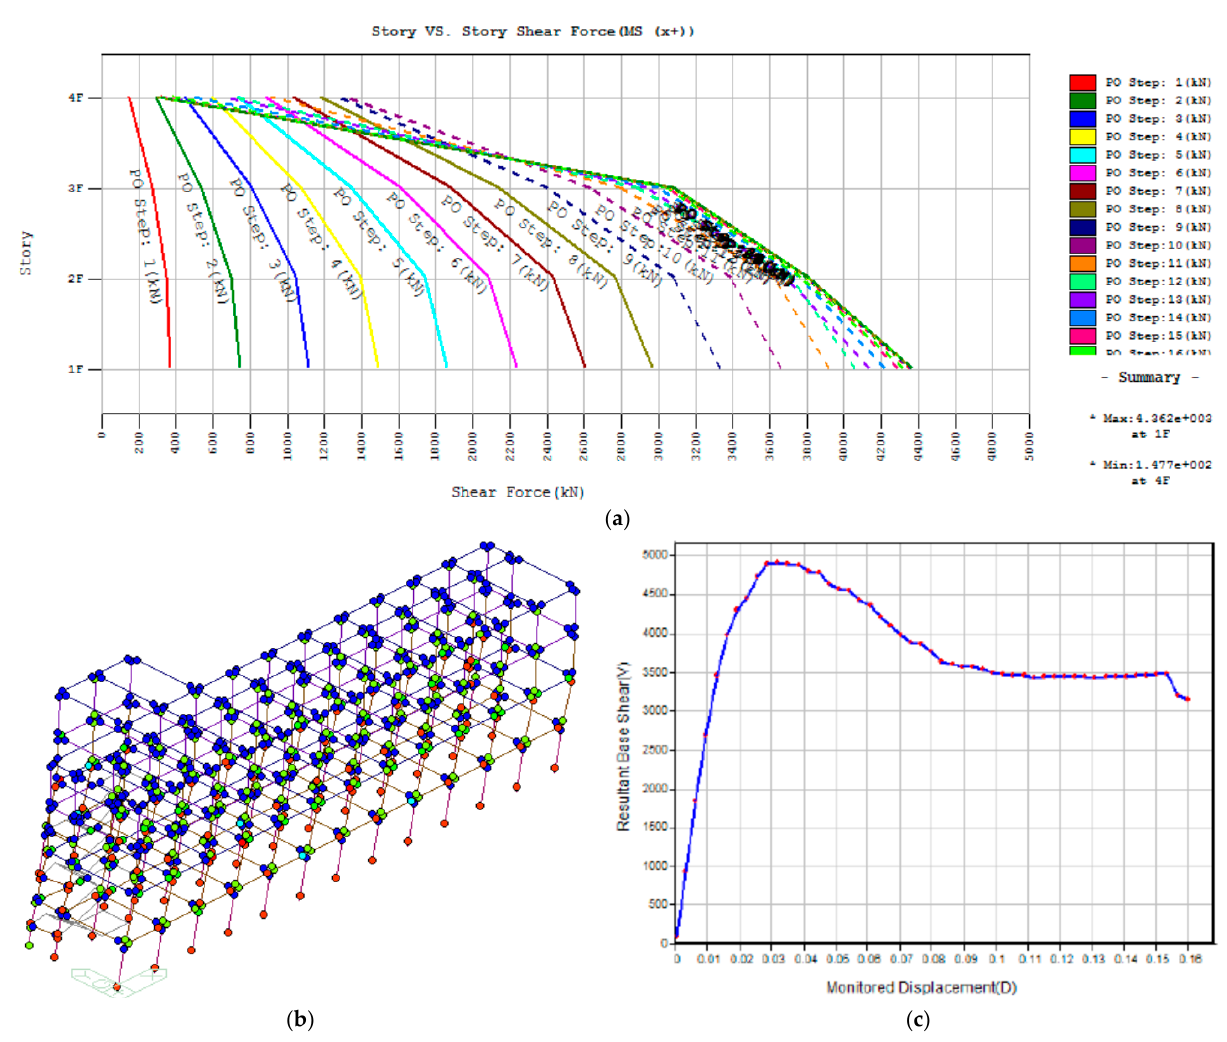
Figure 11. Seismic capacity assessment of MU model, based on PO analysis (Midas): ( a ) shear distribution at different story levels for selected PO steps (MS x+ loading case); an example of ( b ) lumped plasticity damage (UAS x+) and ( c ) measured residual base shear as a function of monitored top displacement (MS y+).